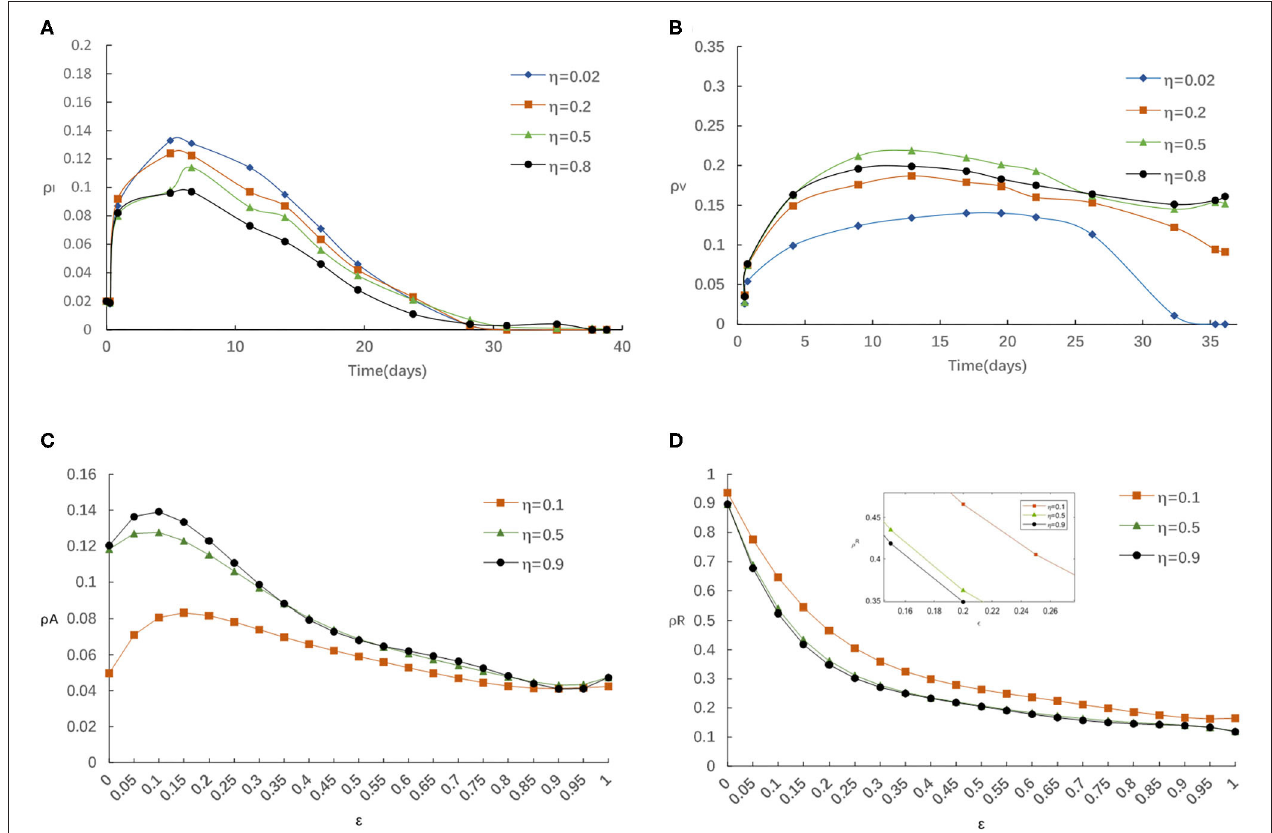
FIGURE 3 | (A) The fraction of infected for various η with α = 0.3, α 0 = 0.2, δ = 0.1. (B) The fraction of vaccinated for various η with α = 0.3, α 0 = 0.2, δ = 0.1. (C) The fraction of aware for various η with α = 0.3, α 0 = 0.2, δ = 0.1. (D) The fraction of recovered for various η with α = 0.3, α 0 = 0.2, δ = 0.1.